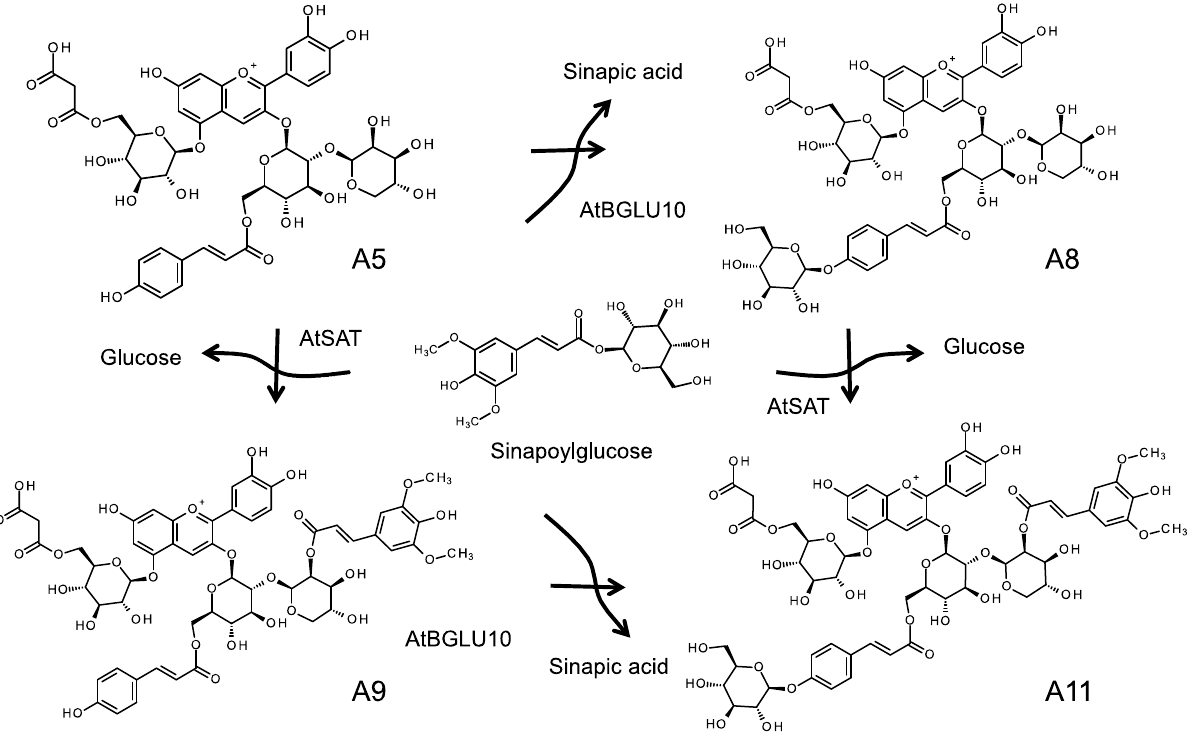
Sinapoylation of the xylosyl group is catalyzed by sinapoylglucose:anthocyanin